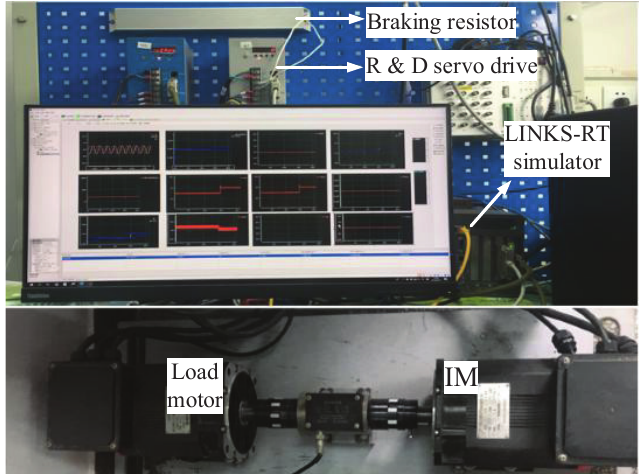
Figure 4. Experimental